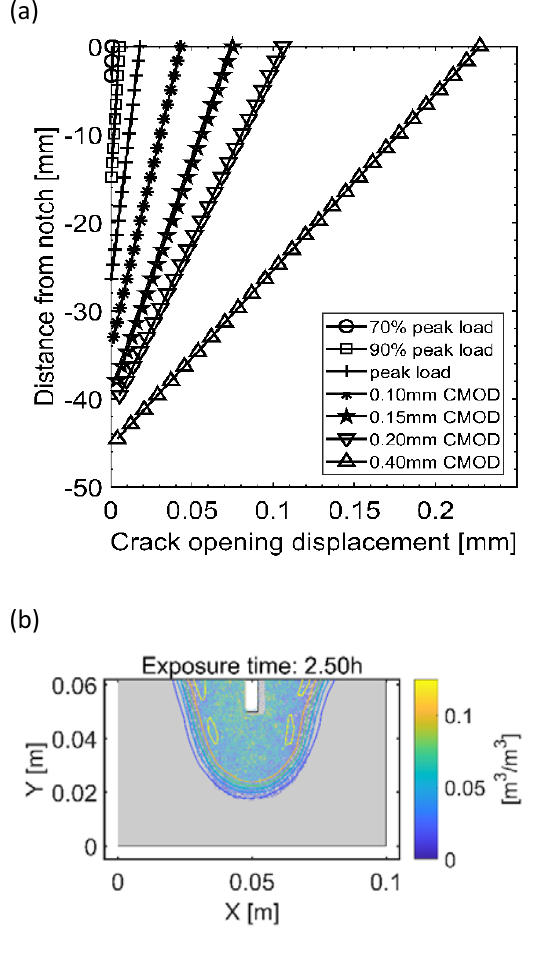
Figure 3. (a) Estimated crack profiles using cracked hinge model [33 ‐ 35] for WST specimens investigated in [30] and (b) experimental and modelled ingress results for 0.1 mm CMOD WST specimen after exposure to liquid water. Please note: color bar indicates (measured and modelled) moisture content in m 3 /m 3 . After